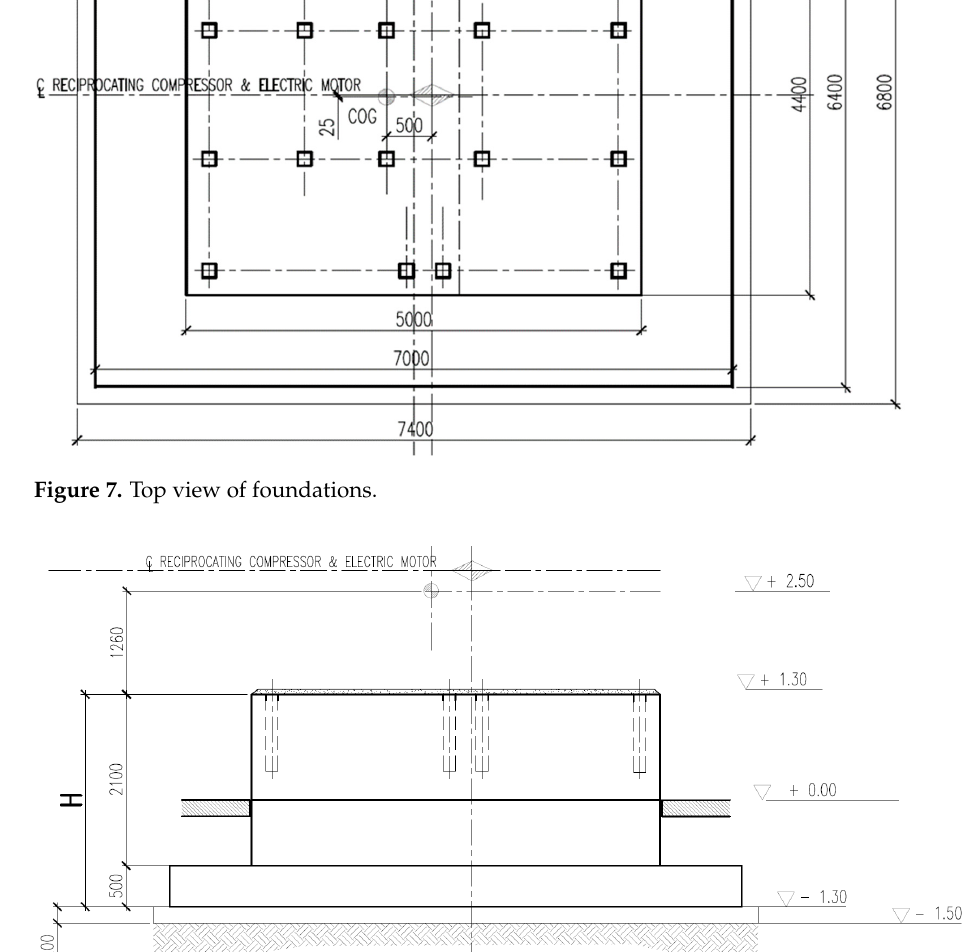
Figure 8. Side view of the foundations.